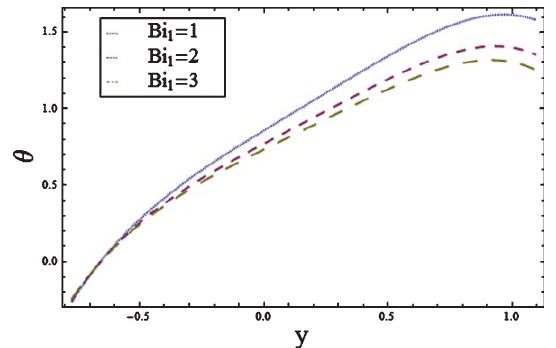
= 10, x = 0 . 2and We = 0 . 2